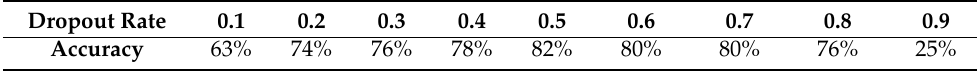
Table 7. Network accuracy with different dropout rate